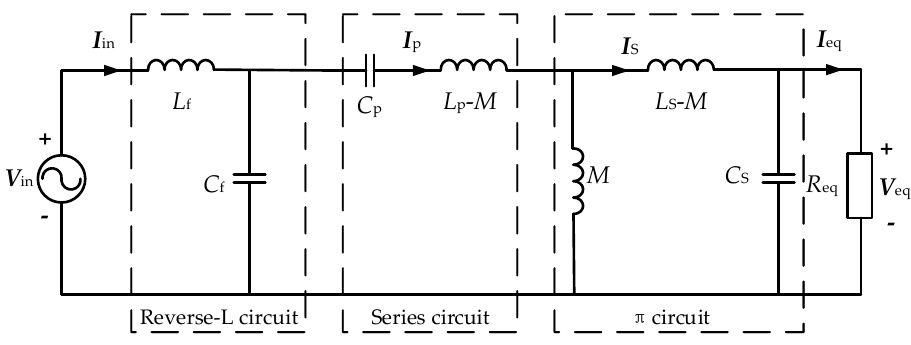
Figure 2. Equivalent circuit of LCC - P topology in CC mode.